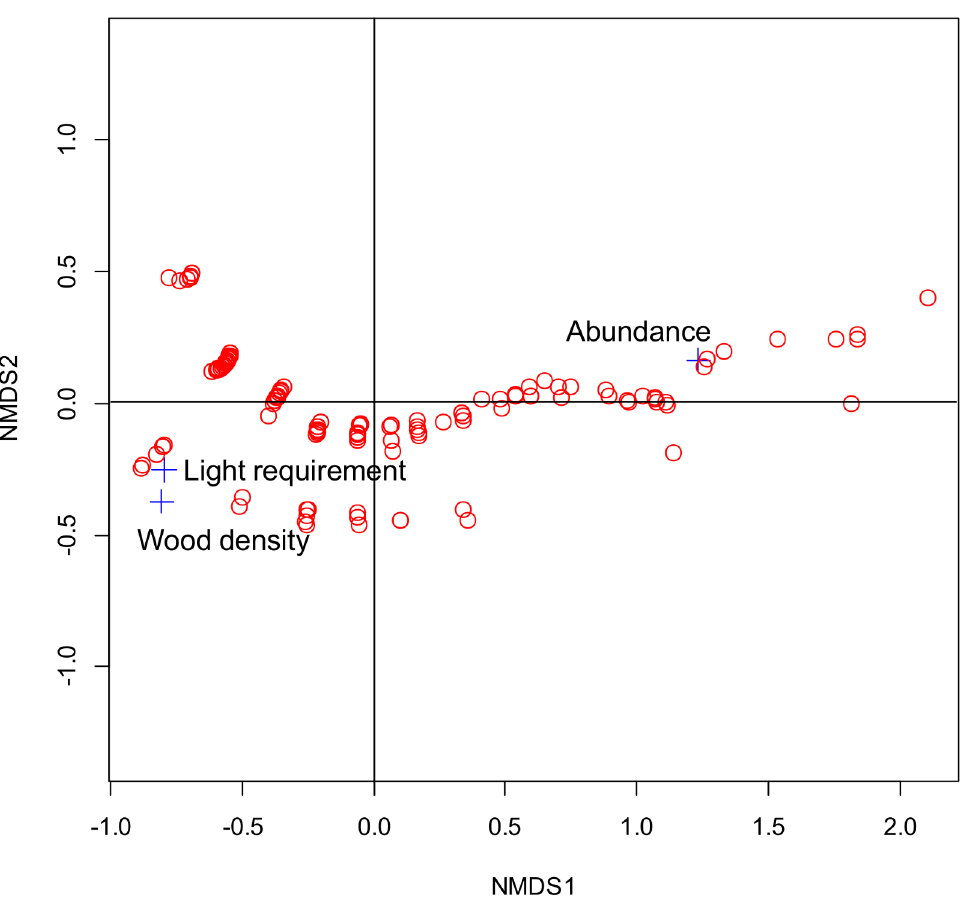
Figure 5. Ordination of wood density, light requirement and relative abundance in the non-metric multidimensional scaling space of tree species. NMD1 and NMDS 2 represent axis 1 and axis 2 of the non-metric multidimensional scaling. The red open circles represent all established tree species (i.e., dbh $ 10 cm) found in the three mix-forest plots.